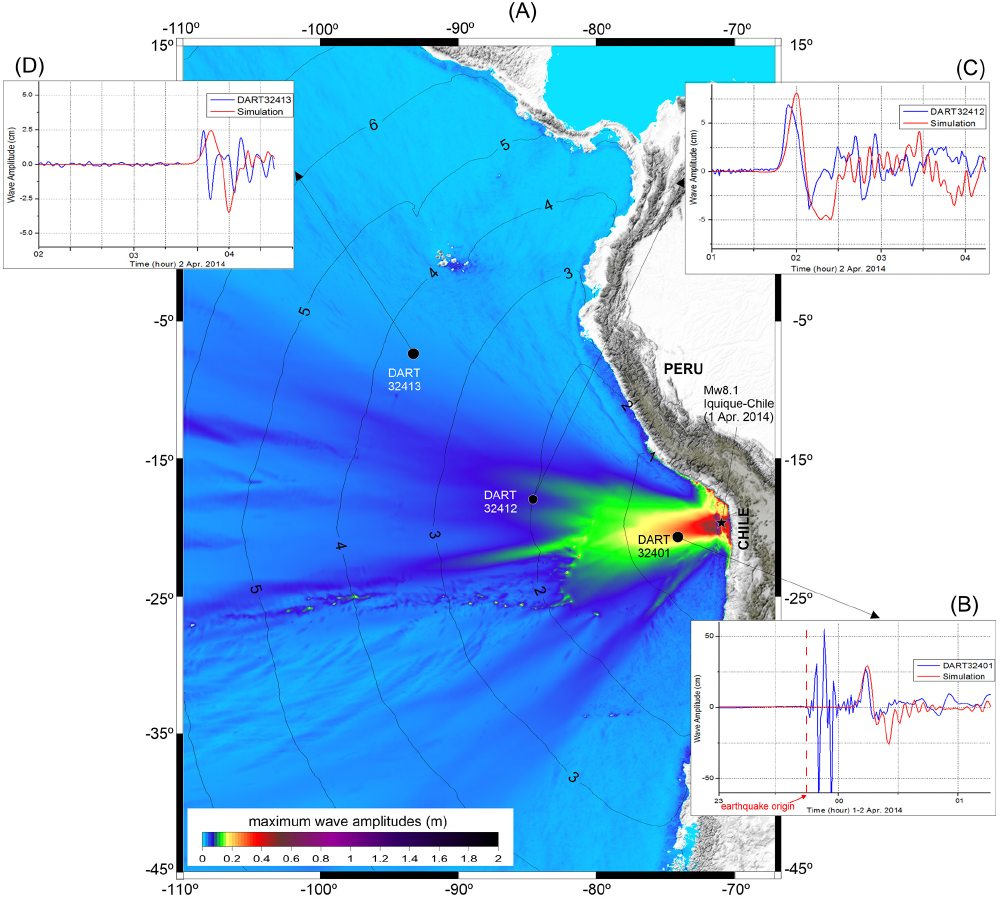
Figure 8. Tsunami numerical simulation of the 1 April 2014 Iquique-Chile tsunami event: (a) maximum wave amplitudes distribution in the east Pacific Ocean and tsunami travel times (dark lines separated each 1h); (b) comparison between the simulated waveform and recorded signal for the station DART ® -32401; (c) comparison between the simulated waveform and recorded signal for the station DART ® -32412; (d) comparison between the simulated waveform and recorded signal for the station DART ®